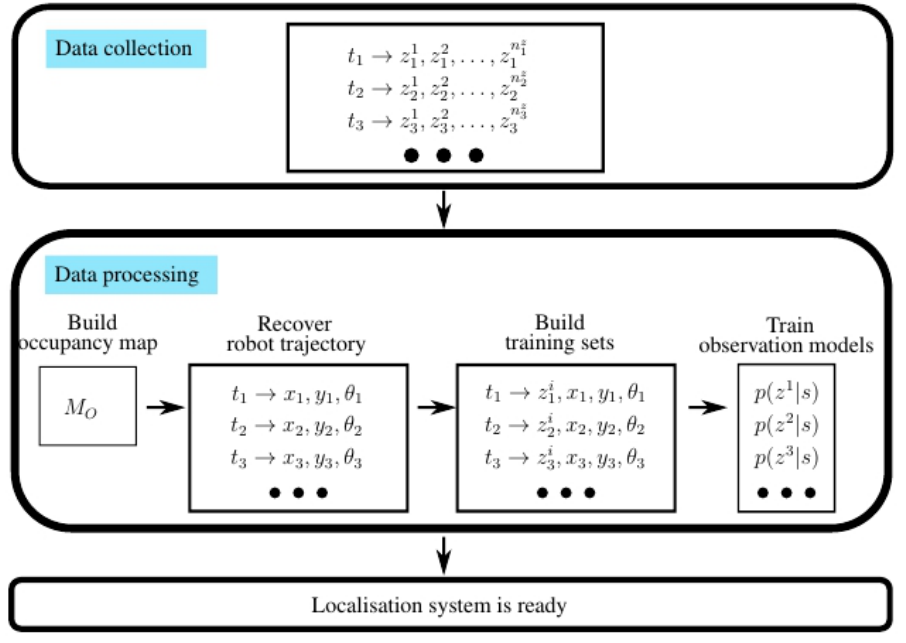
Figure 6. Observation model calibration procedure.